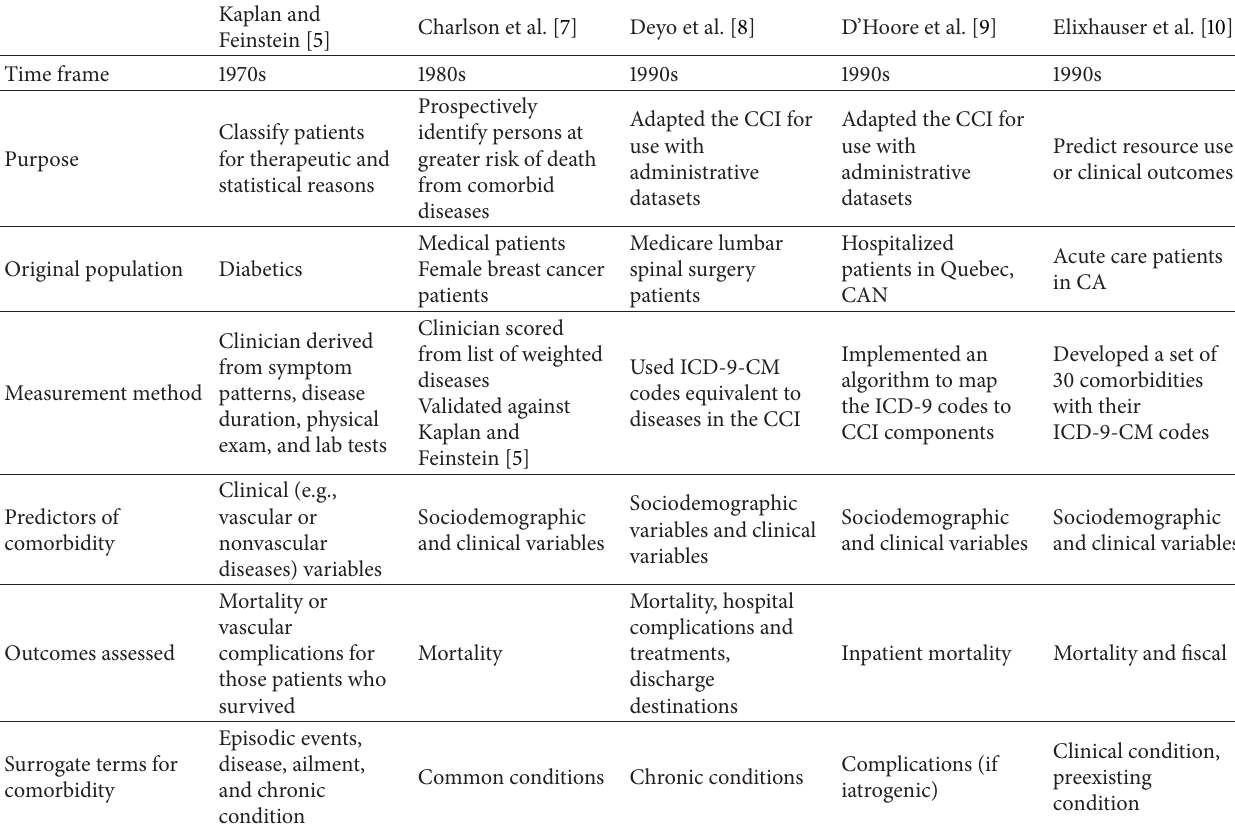
Table 1: Historical overview of the measurement of